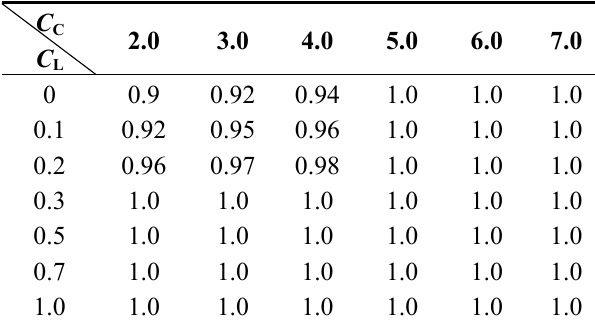
Table 2. Retention ability ( R